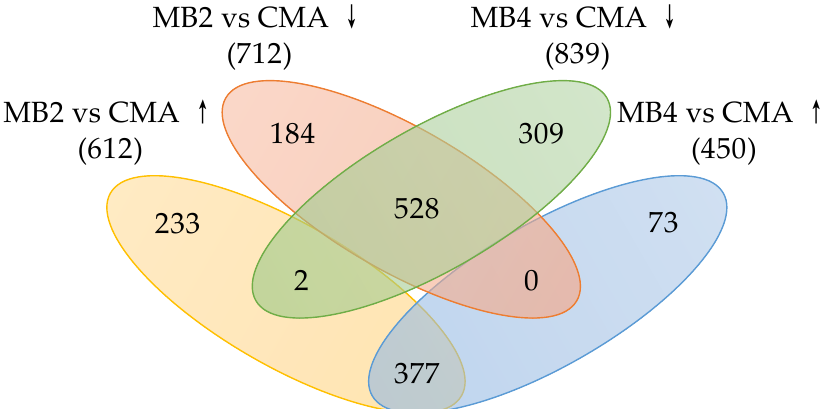
MB4 vs. CMA comparison.